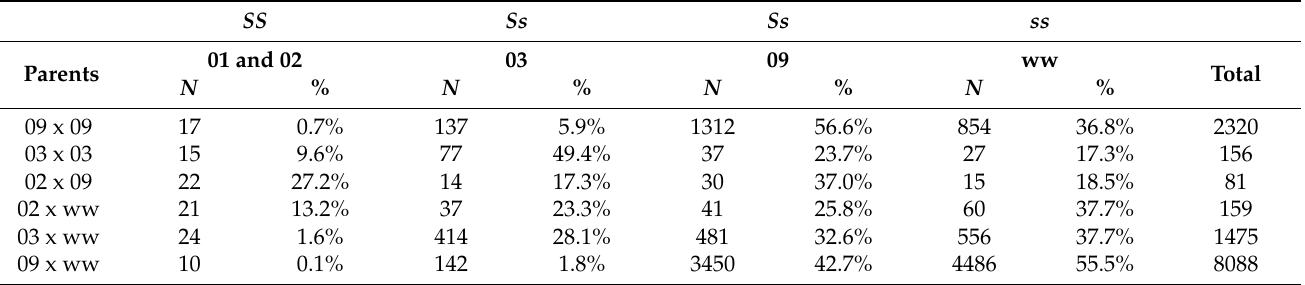
Table 1. Distribution of the offspring from selected crosses in FPL database according to proposed genotypes. Number of 01 x ww crossings unavailable ( N = 12,279).